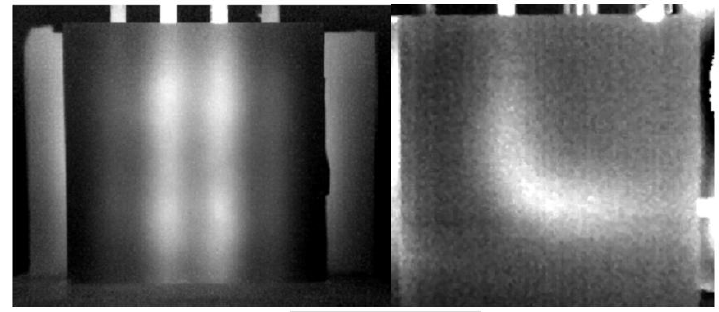
Figure 7. Thermal image for concrete samples using electro-thermography technique to detect rebar (Reproduced from [24] with